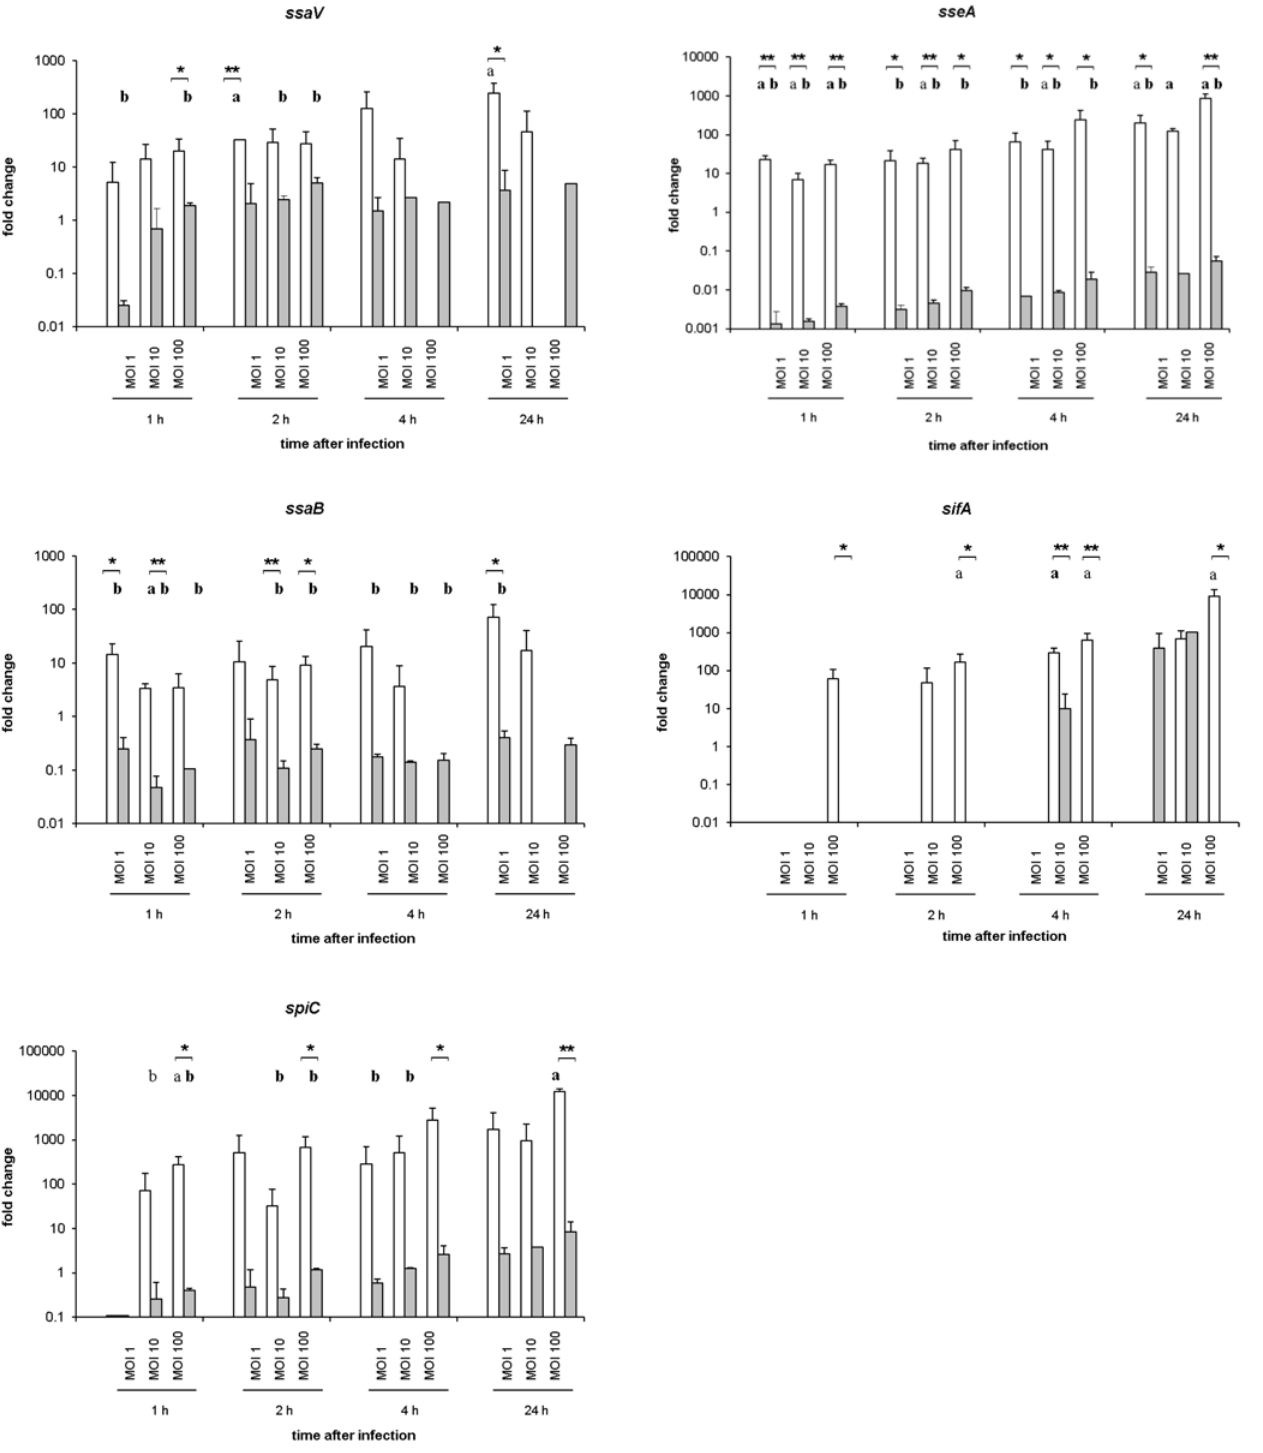
Fig 8. mRNA expression levels of SPI-2-associated genes of S . Typhimurium and S . Infantis in avian splenic macrophages. Data were presented as fold change compared to bacteria before infection. White columns — macrophages infected with S . Typhimurium (n = 6), Grey columns — macrophages infected with S . Infantis (n = 6) ** P (cid:2) 0.05 or * P (cid:2) 0.1 S . Typhimurium vs. S . Infantis; a ) P (cid:2) 0.05 or a) P (cid:2) 0.1 S . Typhimurium vs. control; b ) P (cid:2) 0.05 or b) P (cid:2) 0.1 S . Infantis vs. control.